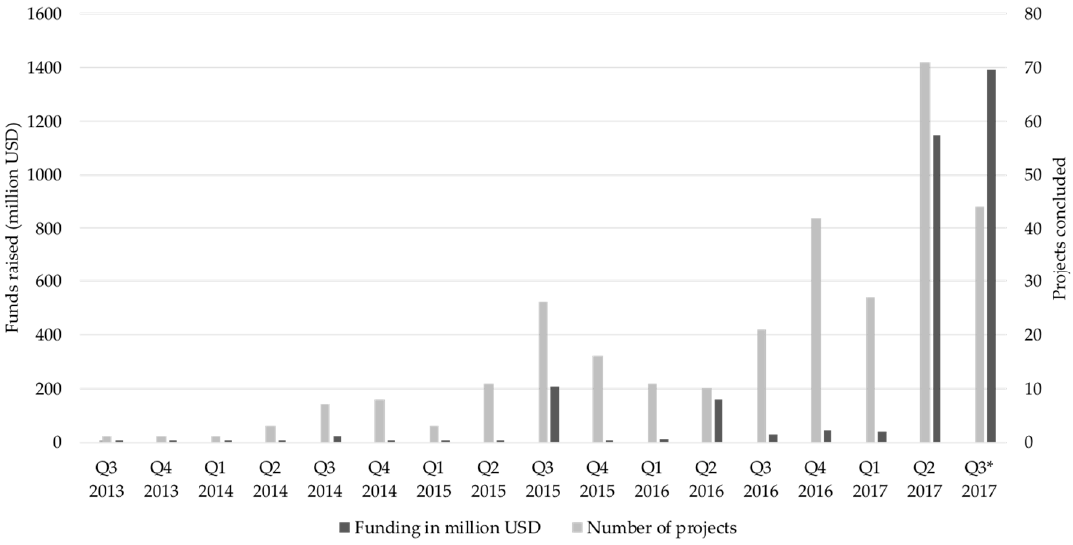
Figure 2. Number of ICOs and ICO funding in million US-dollars over time. Q3* 2017 has been interpolated for the remaining part of the quarter.